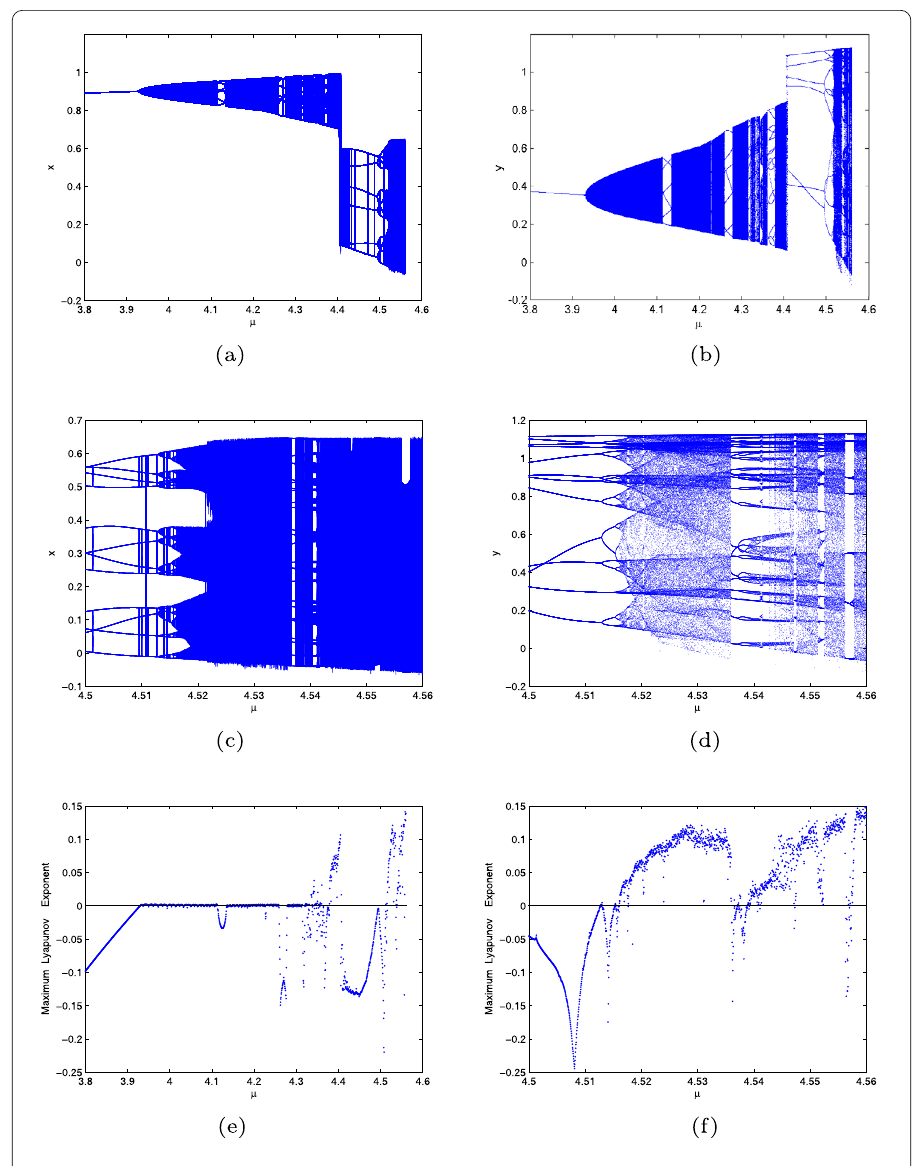
Figure 2 ( a ) Bifurcation diagram of map (2) in ( μ , x ) plane for ρ 1 = 0.3, ρ 2 = 0.8 and μ ∈ [3.8,4.6]. The initial point is (0.899,0.354). ( b ) Bifurcation diagram of map (2) in ( μ , x ) plane corresponding to (a). ( c ) Local amplification corresponding to (a) for μ ∈ [4.54.56]. ( d ) Local amplification corresponding to (b) for μ ∈ [4.5,4.56]. ( e ) Maximum Lyapunov exponents (MLE for short) corresponding to (a) and (b). ( f ) Local amplification corresponding to (e)